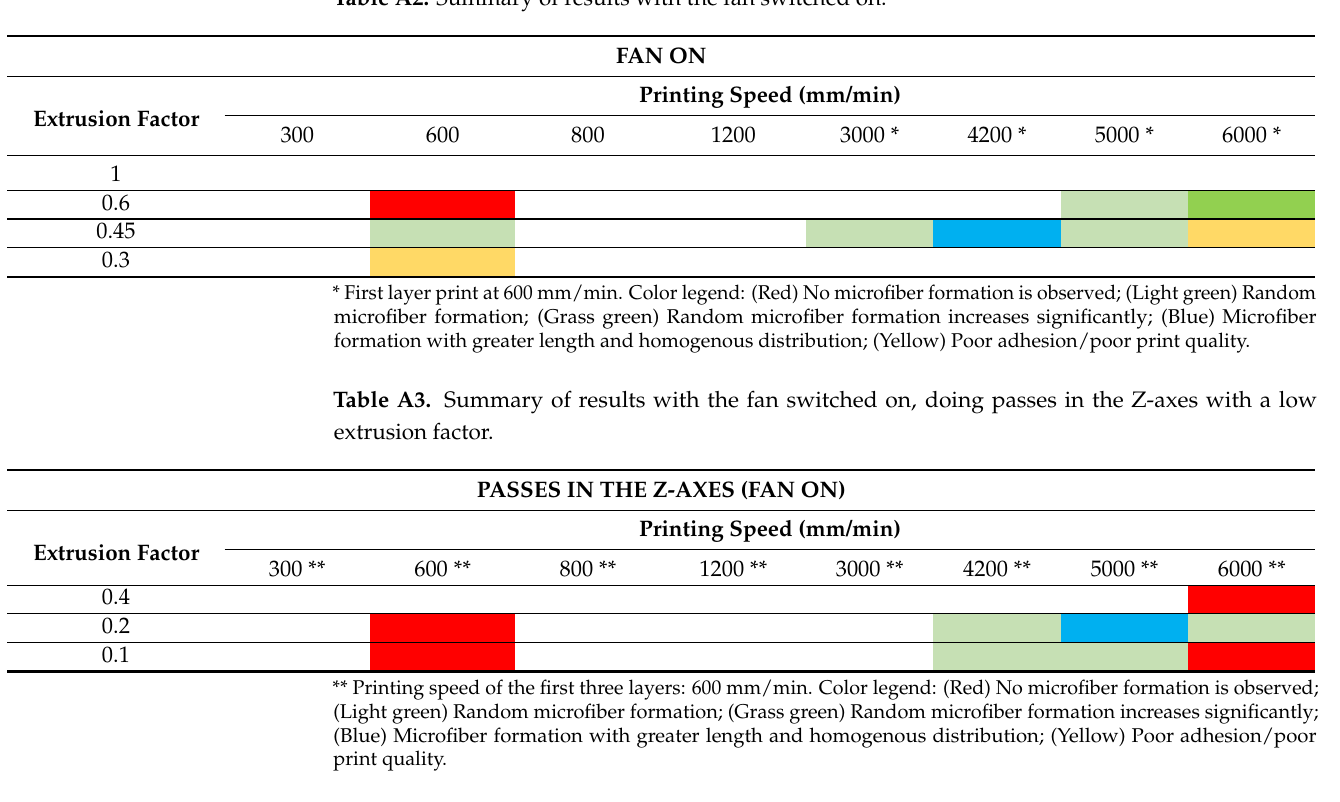
Table A2. Summary of results with the fan switched on.